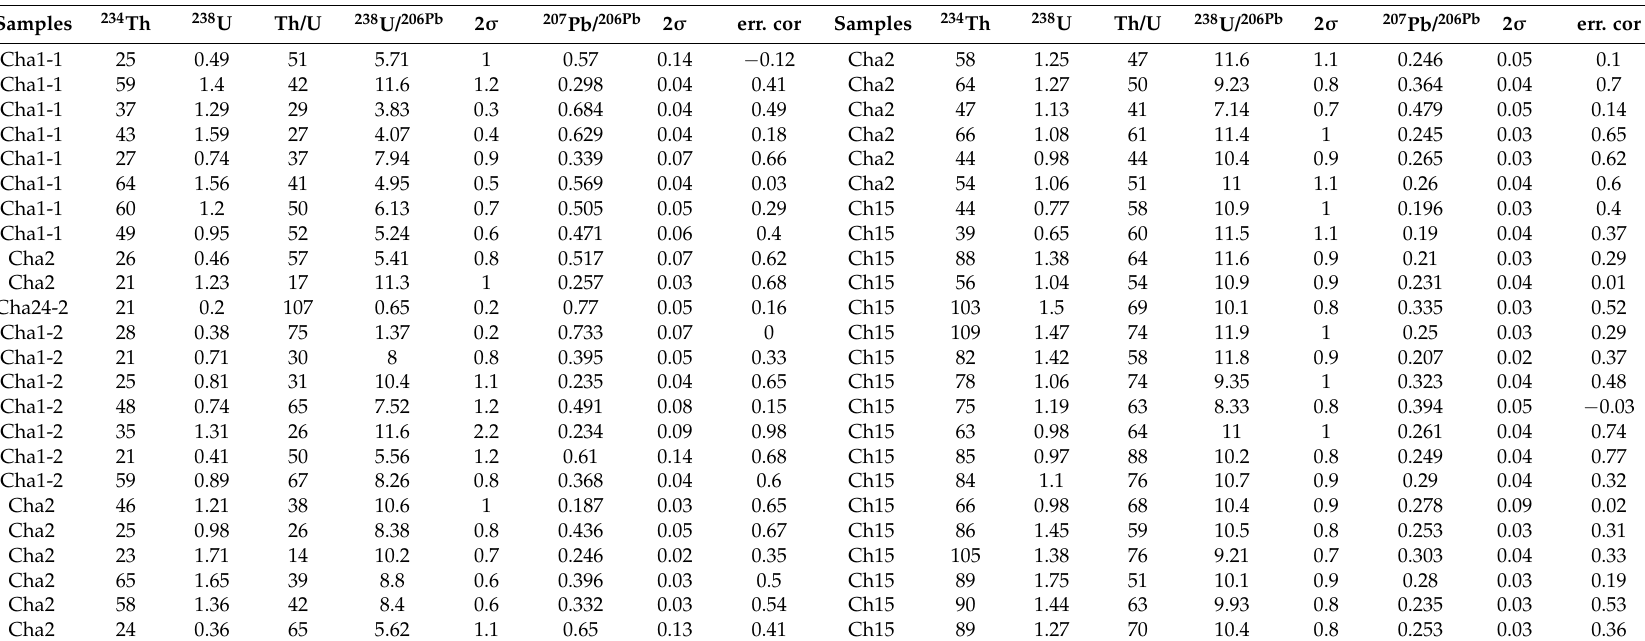
Table 9. U-Pb-Th isotope compositions and isotope ratios for the dark, low-REE apatites, Chadormalu deposit (abundances in ppm).